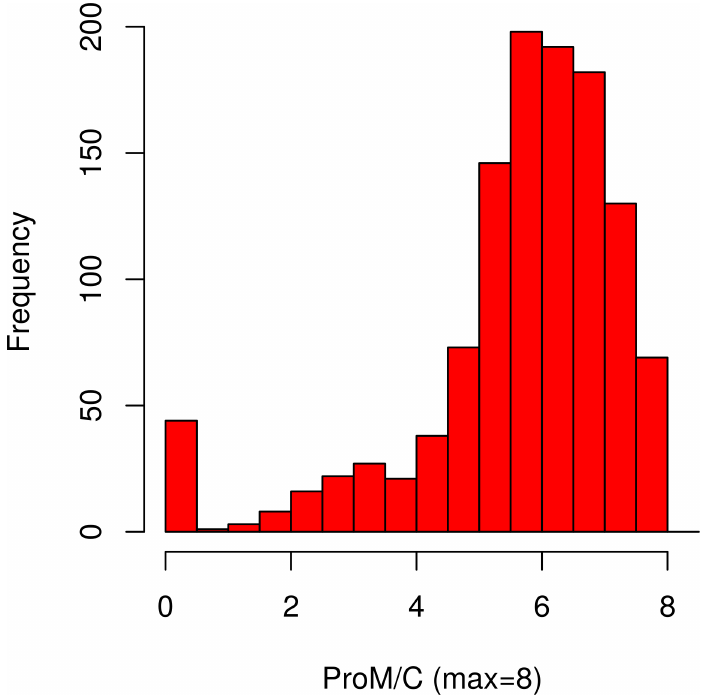
Fig 1. Distribution of ProM/C (continuous measure of ProM). The distribution of ProM/C was relatively normal with a negative skew. Only a small number of participants scored at the floor or at the ceiling.